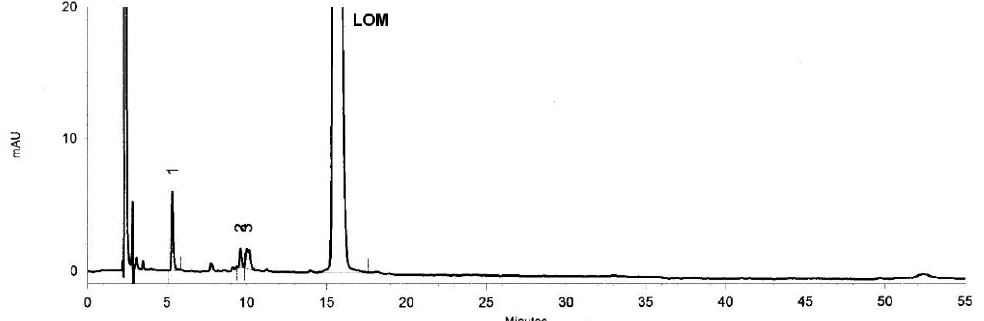
Figure 7. Chromatogram of LOM after oxidation by H 2 O 2 after incubation for 168 h.